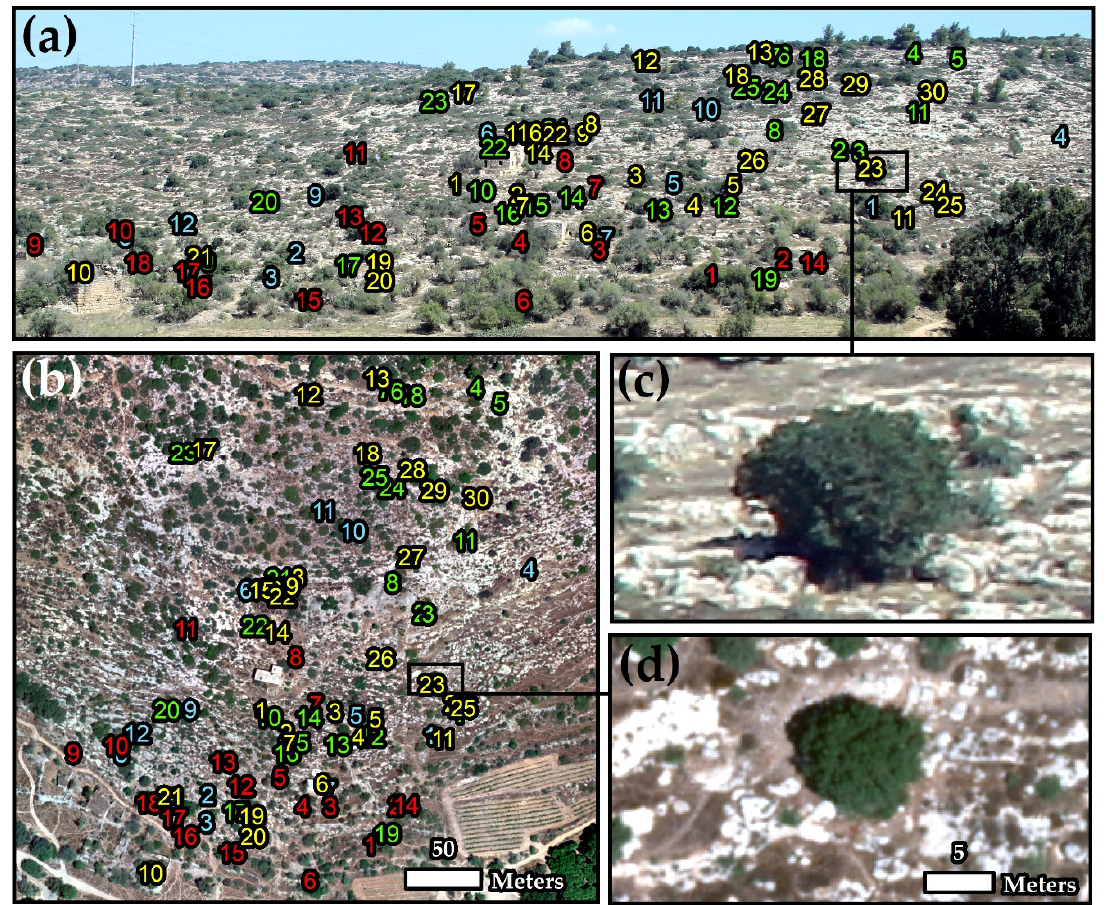
Figure 4. Identification of four different woody Mediterranean species at the individual plant level. Palestine oak in yellow, Terebinth in red, Mastic in green, and Carob in blue, over true color ground photo ( a ) and the 14 cm true color UAV mosaic ( b ), which were both acquired on 6 August 2018 at Mata. The two photos on the bottom right present an individual oak tree as acquired by the ground camera ( c ) and the UAV ( d ).